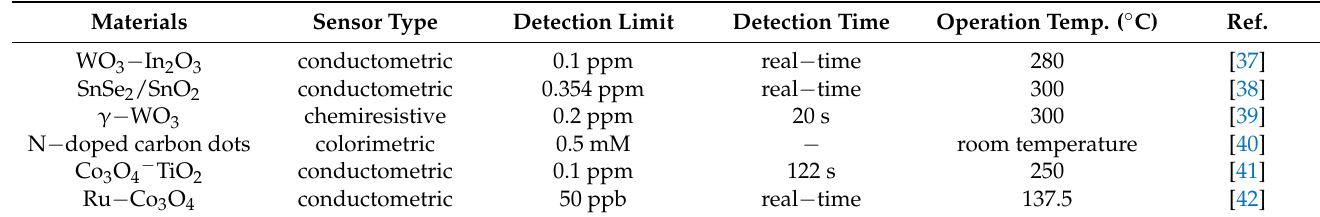
Table 3. Acetone sensing properties of with various types of reported sensing materials.